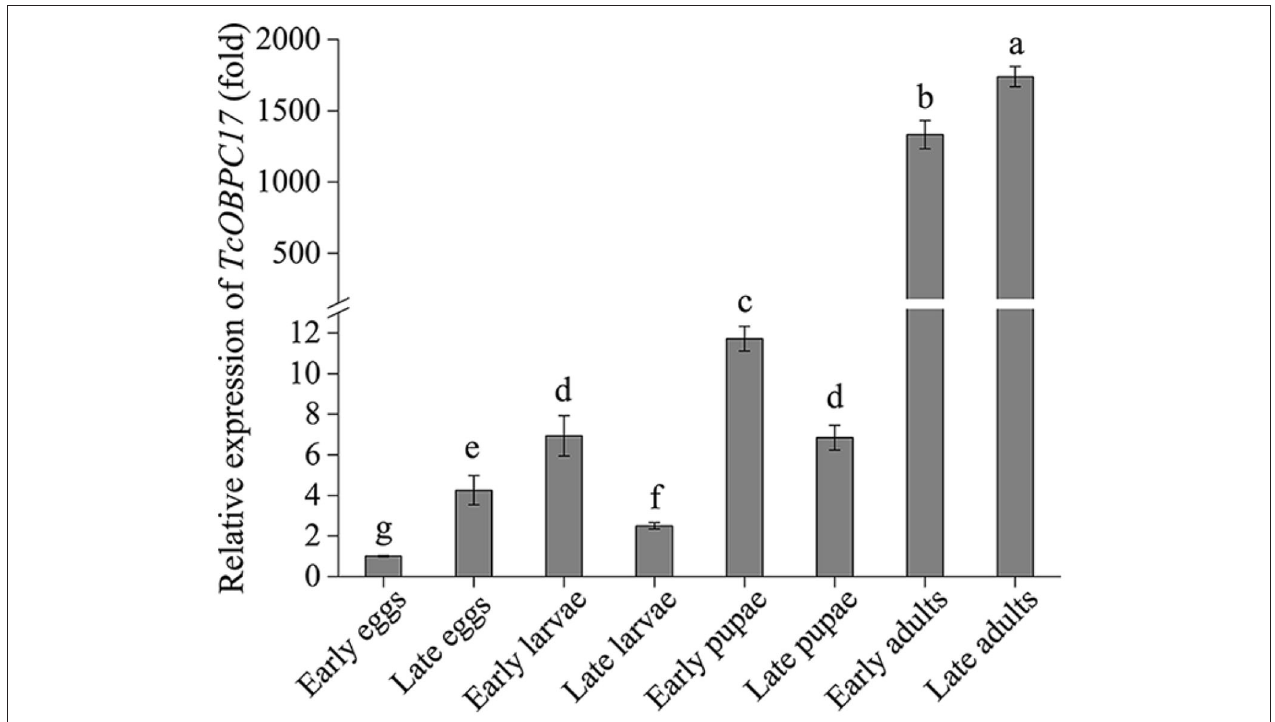
FIGURE 1 | Expression of TcOBPC17 at eight different developmental stages of T. castaneum : early and late eggs (1 and 3 days old), early and late larvae (1 and 20 days old), early and late pupae (1 and 5 days old), early and late adults (1 and 10 days old). The transcript level of TcOBPC17 in early eggs was used as a calibrator of developmental expression profile. The bars represent standard errors of the means ( n = 3–5). Fisher’s least significant difference (LSD) test was employed to analyze the significant difference between the means, and different letters above the bars represent significant differences in means at P < 0.05.